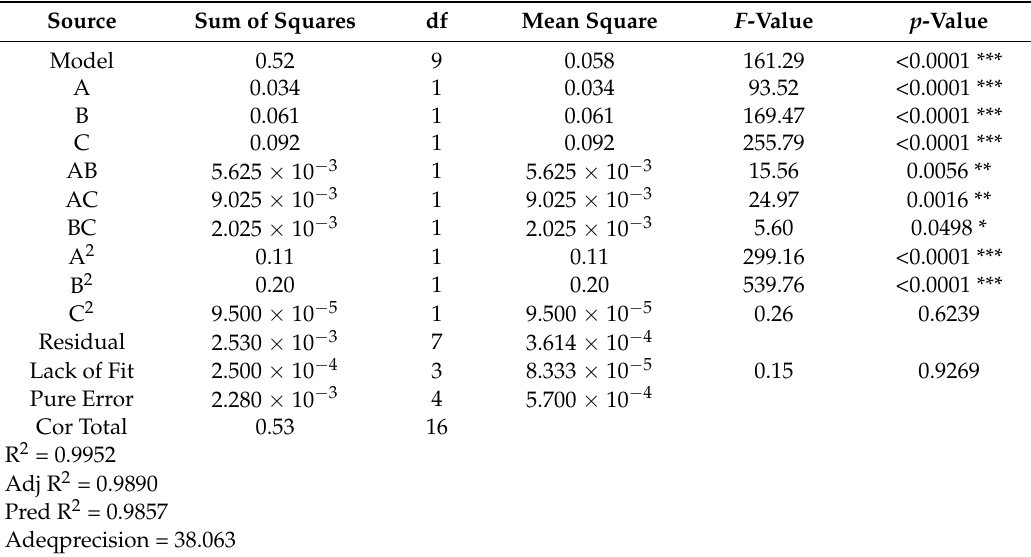
Table 2. ANOVA analysis for ‘Gannanzao’ orange essential oil (GOEO)